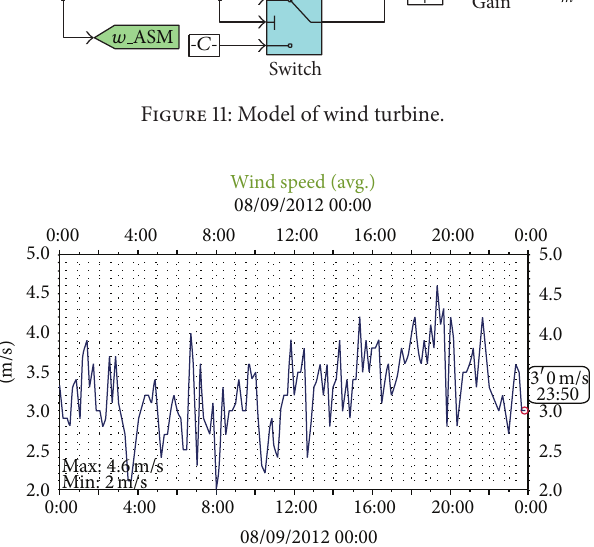
Figure 12: Wind speed data of a typical day at KEC, Erode, TN,